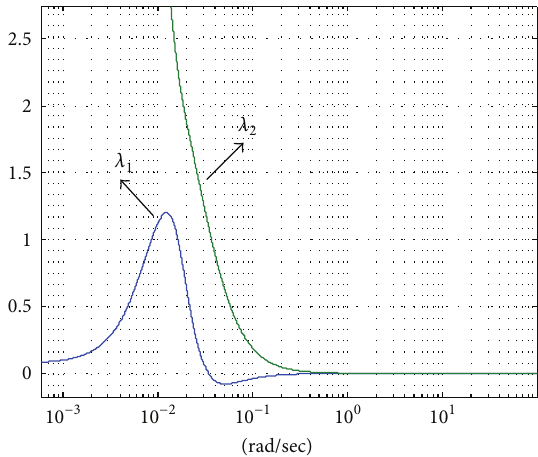
Figure 5: Eigenvalues of [𝐺 𝑜2 (𝑗𝜔) + 𝐺 ∗ 𝑜2 (𝑗𝜔)] (Case 2 ).